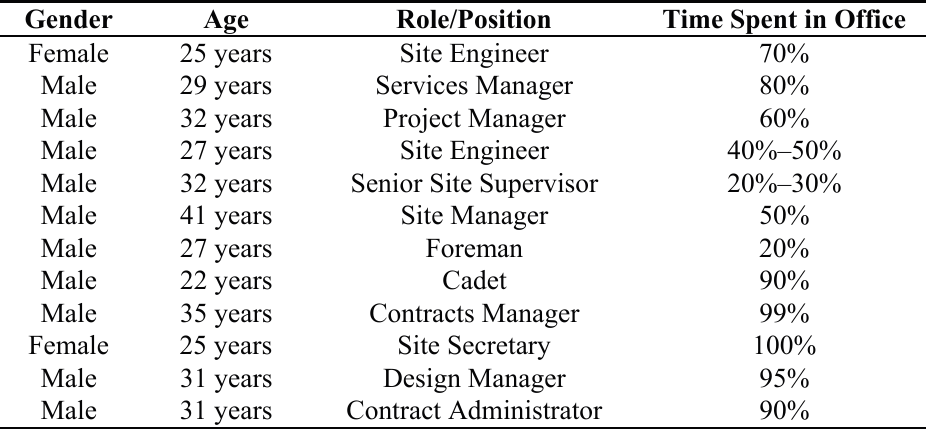
Table 3. A snapshot of the demographics of